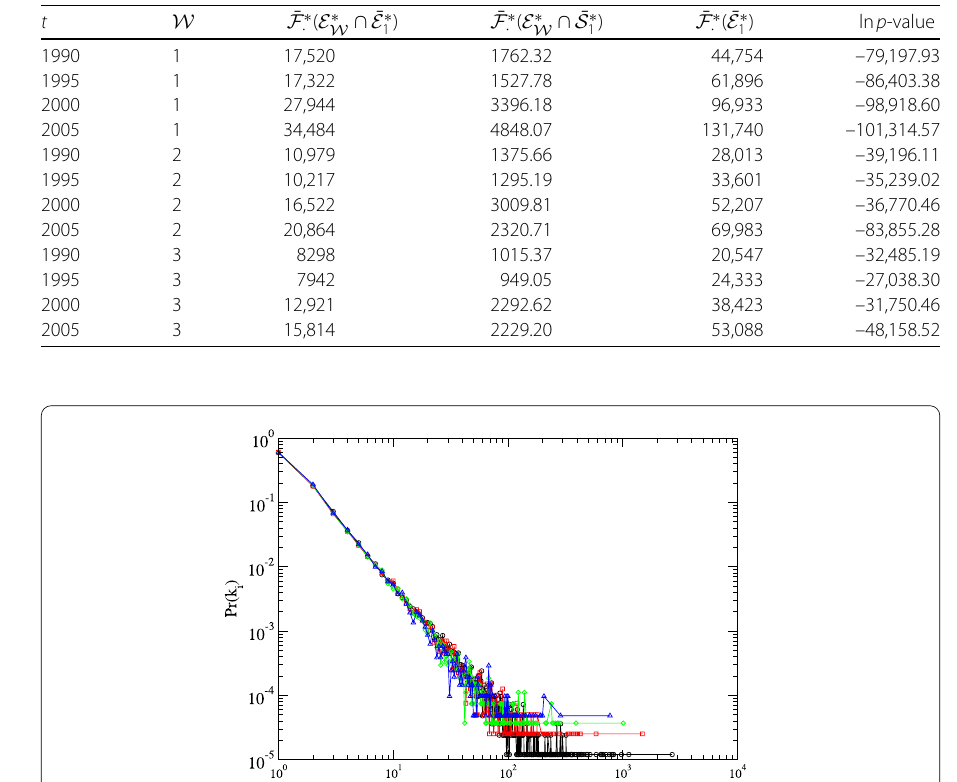
Table 4 Table for test of overall flow carried by node pairs predicted by threshold test. The table only includes (cid:2) t = 2, as other values of (cid:2) t have only a minor effect on the probability densities θ ( HF ) and θ W . We show a selection of years for each of the three values of W = 1,2,3. Note that the p -values are exceedingly